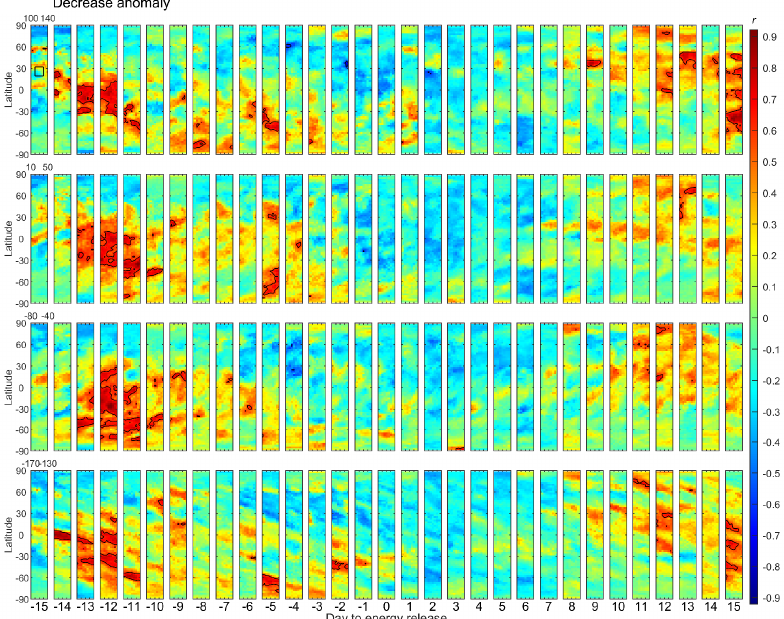
Figure 9. Temporal and spatial distributions of correlation coefficient between the daily seismic wave energy release ≥ M 5.5 with the outliers within Region B and the occurrence times of the TEC decrease anomalies. Panels from left to right represent –15 to 15 days from the seismic wave energy release (D). Top to bottom panels display the four selected longitude sectors centered over 120, 30, –60, and –150 °E, respectively, each with a width of ±20°. The contour denotes r α = 0 . 01 according to sample size at each D. The black box on the top first panel indicates Region C.